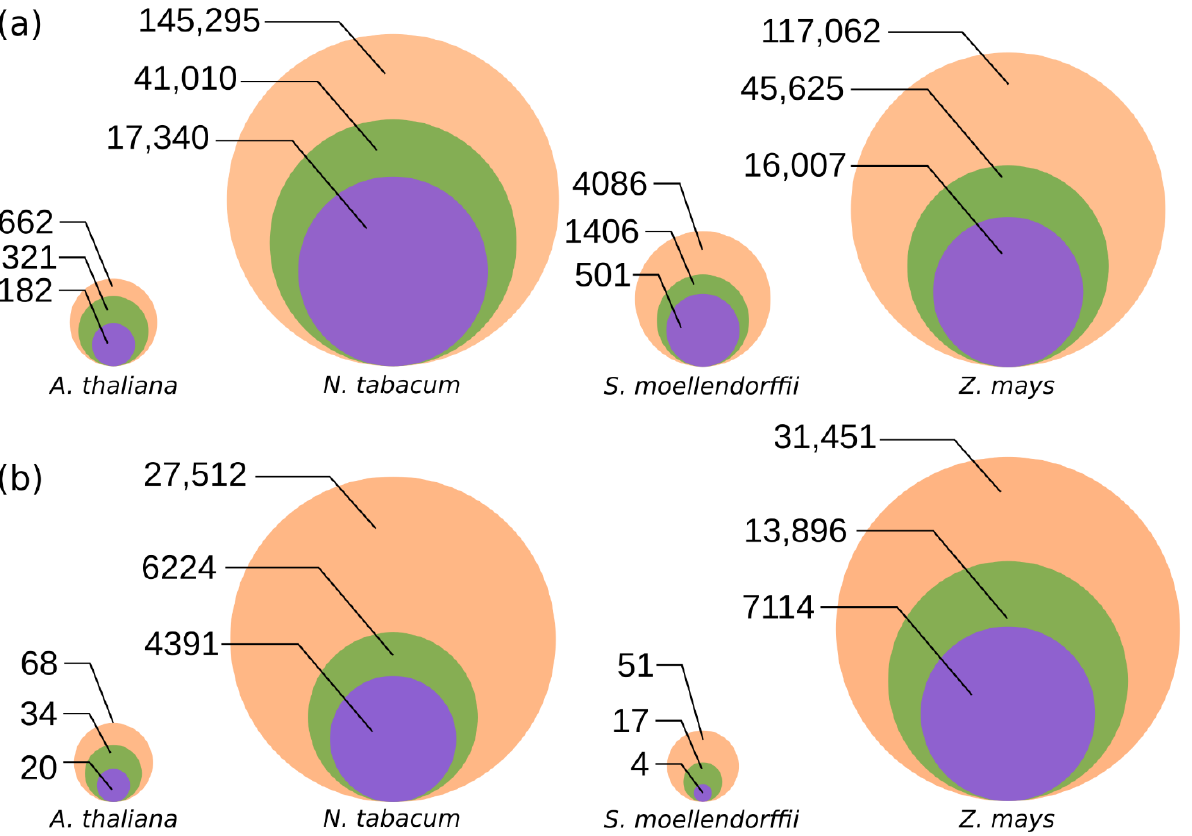
Figure 2. Sensitivity of LTR retrotransposon (LTR-RT) identification by the DARTS and LTRharvest pipelines. Orange circles—number of elements found by DARTS; green circles—number of LTR-RTs found by DARTS with predicted LTRs; purple circles—number of elements found by LTRharvest. Sizes of the circles are proportional to the number of elements with relation to the minimum and the maximum values. Exact numbers of elements are indicated to the left of the circles. Parameters of the LTRharvest search were the same for both the approaches ( a , b ). ( a ) Prediction of LTR-RTs by DARTS when the search was initiated from the RT domain; LTRharvest elements were retained if the RT domain was present. ( b ) Prediction of LTR-RTs by DARTS when the search was initiated from the aRNH domain; DARTS and LTRharvest elements were retained if both the RT and aRNH domains were present.